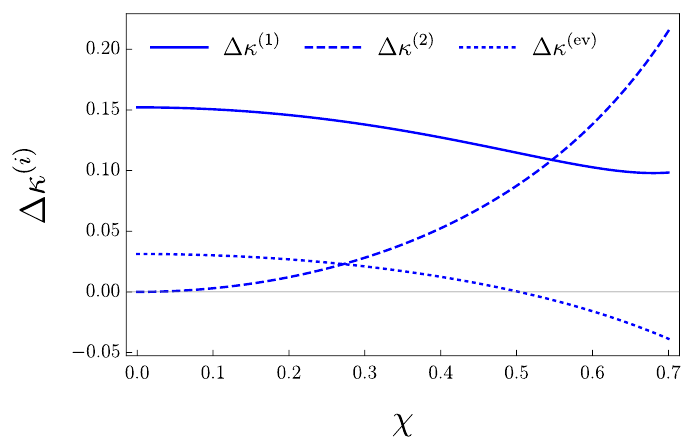
Figure 2 . Variation of the surface gravity (cid:1) (cid:20) ( i ) due to every correction, as a function of (cid:31) . We can observe that contributions coming from curvature-squared terms always increase the